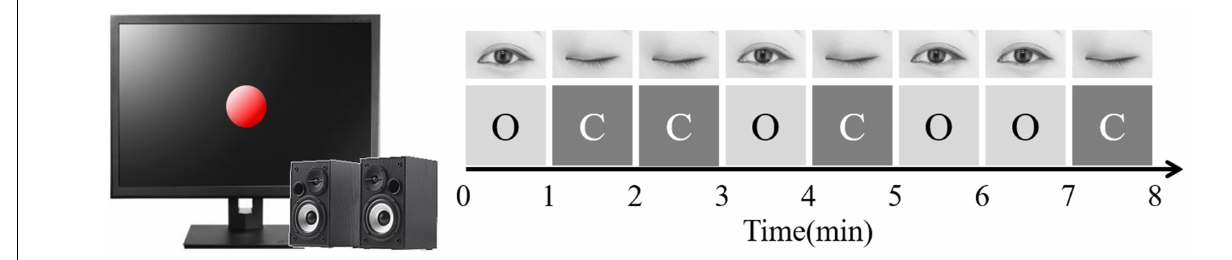
FIGURE 2 | Rest task procedure. “O” means “open,” “C” means “closed.”